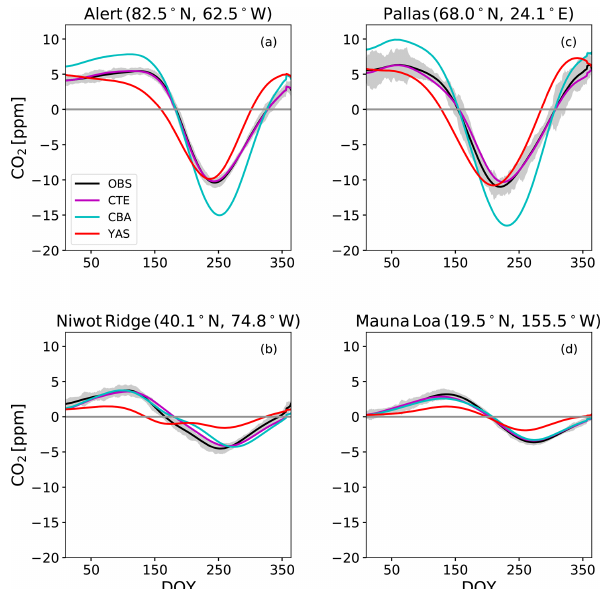
Figure 7. The detrended seasonal cycles of atmospheric CO 2 at four Global Atmospheric Watch sites, Alert (a) , Pallas (c) , Niwot Ridge (b) and Mauna Loa (d) , for observations (OBS) in black, Car- bonTracker Europe 2016 (CTE) in magenta and the two JSBACH model versions with CBALANCE (CBA) with the cyan lines and Yasso (YAS) with the red lines. The solid grey line denotes the zero line. The grey shaded area shows the standard deviations of the ob- servations after detrending. DOY denotes day of year.